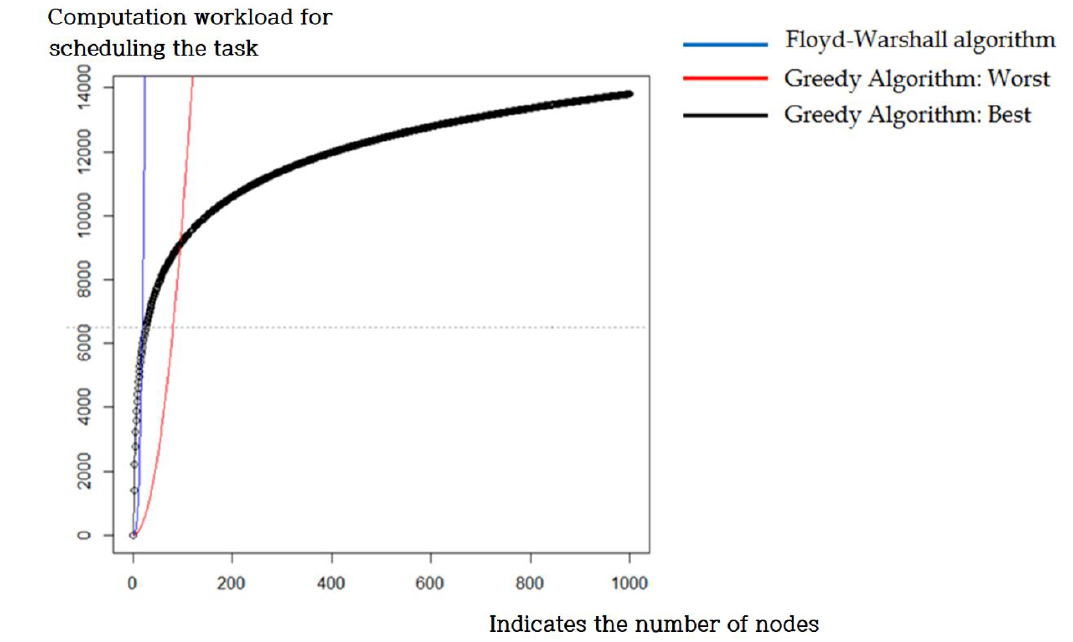
Figure 18. Comparison of time complexities between the Greedy algorithm and the Floyd – Warshall algorithm using R Studio. (X axis: Number of nodes, Y axis: Amount of calculation).